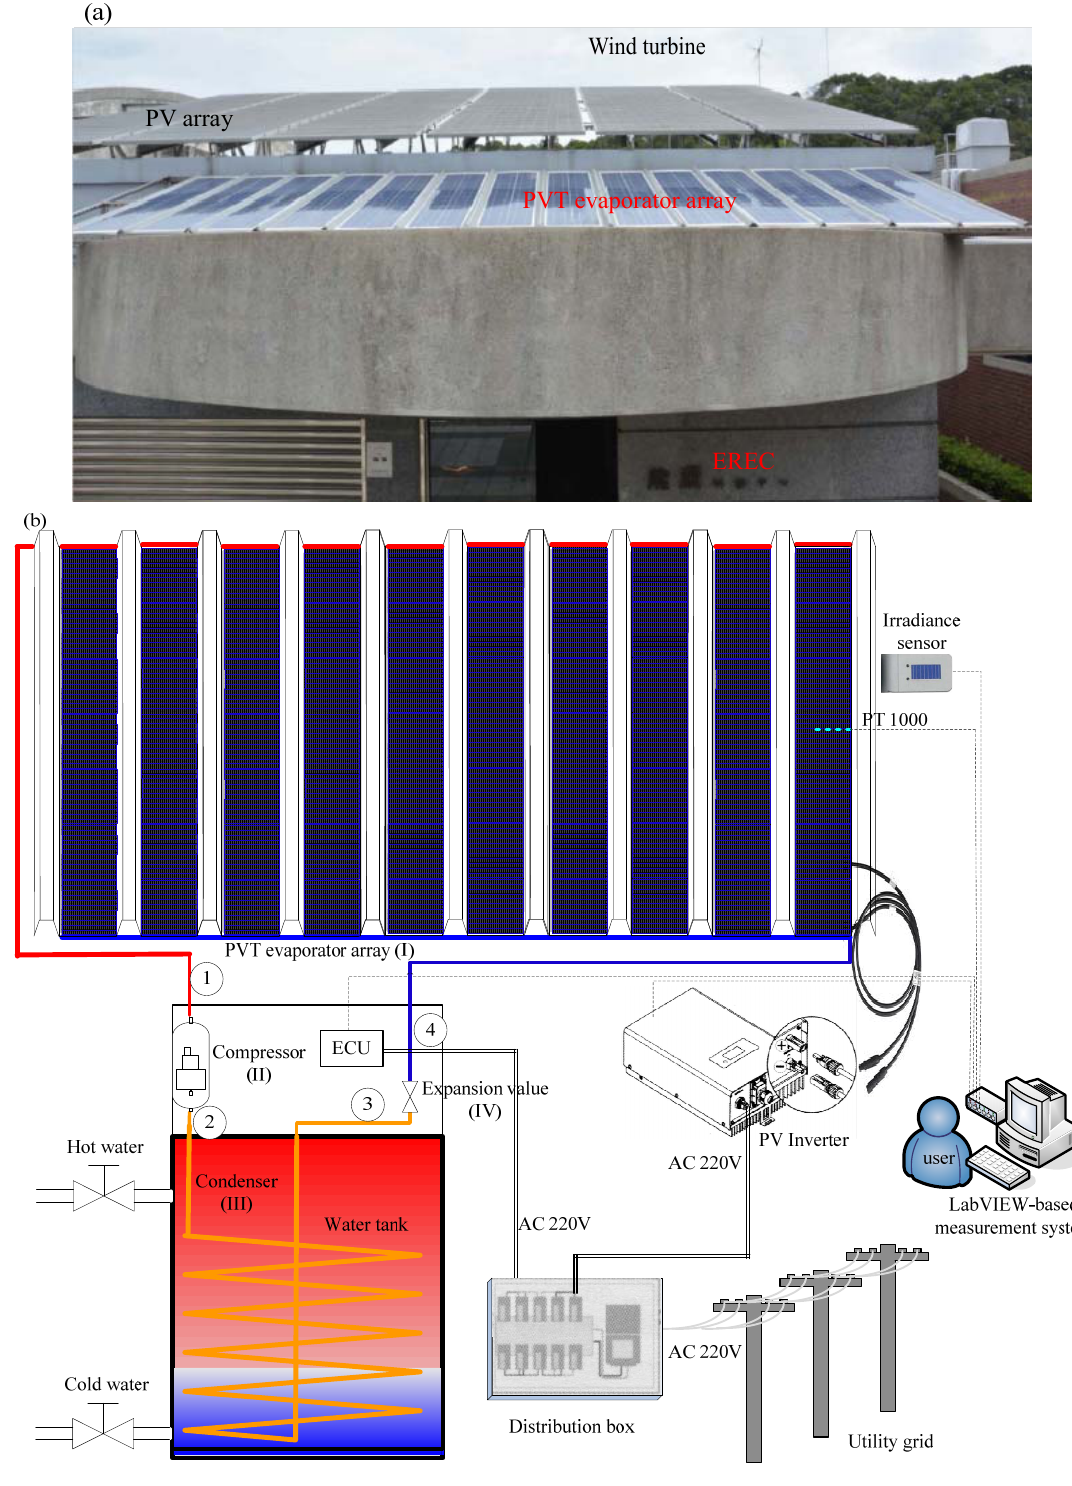
Figure 3. PVTA-HPWH system: ( a ) photo of PVT evaporator array; ( b ) PVTA-HPWH test